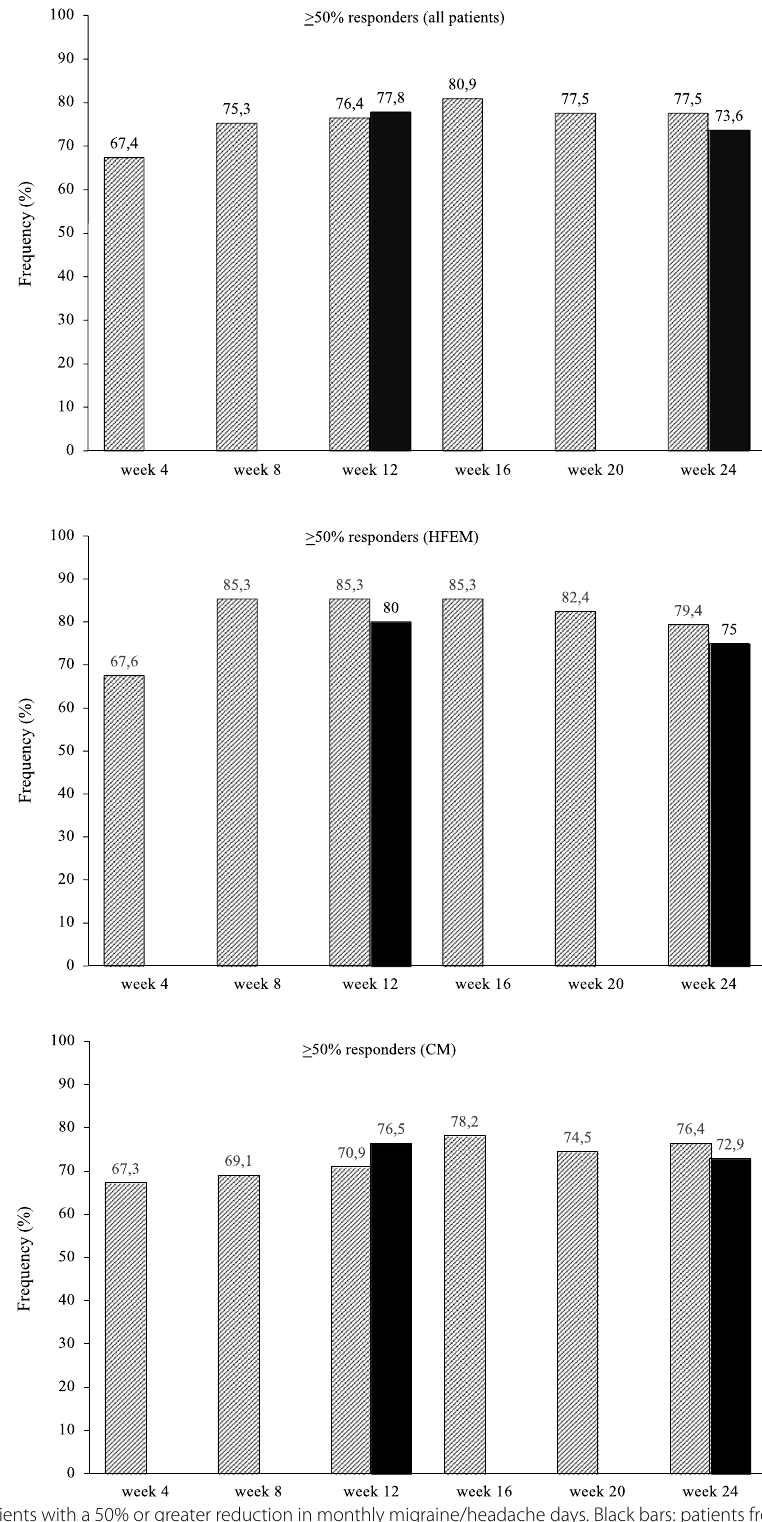
Fig. 3 Proportion of patients with a 50% or greater reduction in monthly migraine/headache days. Black bars: patients from headache centersproviding data at weeks 12 and 24 ( n 148). Hatched bars: patients from headache centers providing data at weeks 4, 8, 12, 16, 20 and 24 = ( n 89). HFEM: high-frequency episodic migraine; CM: chronic =